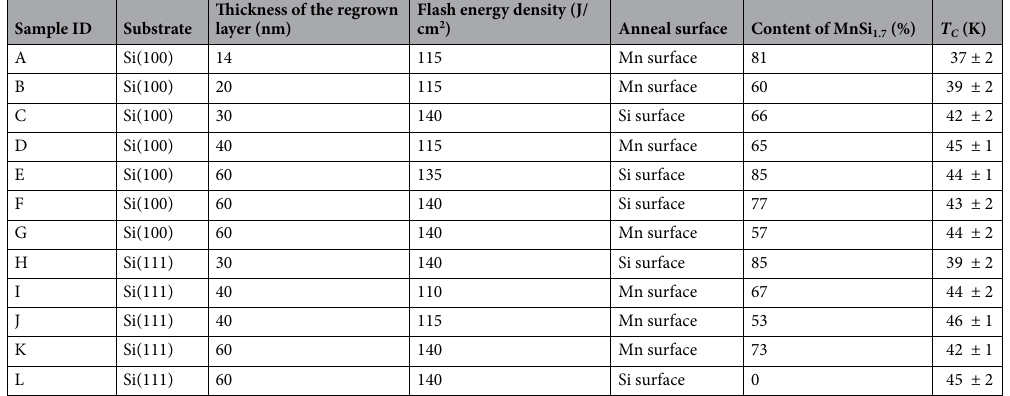
Table 1. The parameters of the samples and their Curie temperature ( T C ).